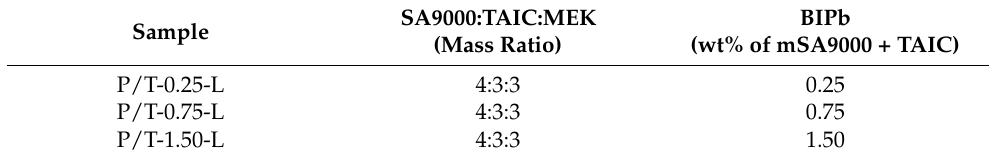
Table 2. The composition of prepreg and laminate